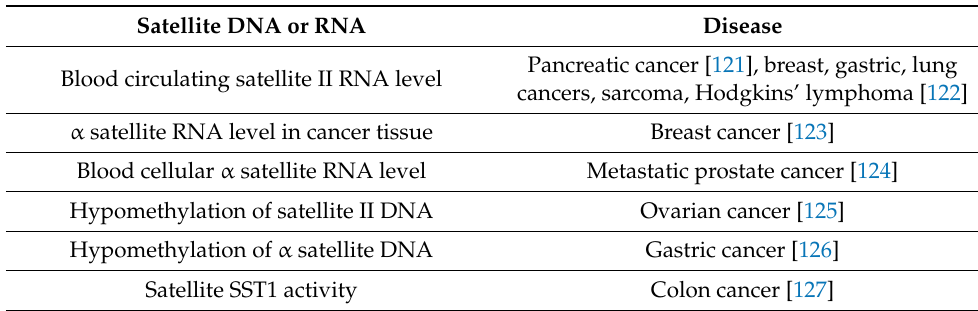
Table 1. List of satellite RNAs and DNAs associated with particular diseases for which they could serve as diagnostic or prognostic